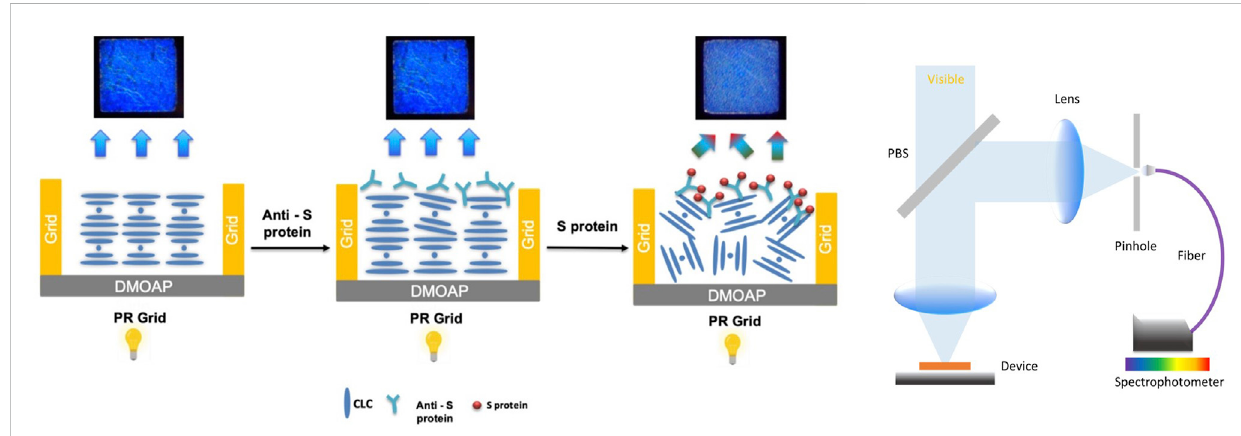
FIGURE 1 Schematic diagram of the detection mechanism of the cholesterol liquid crystal